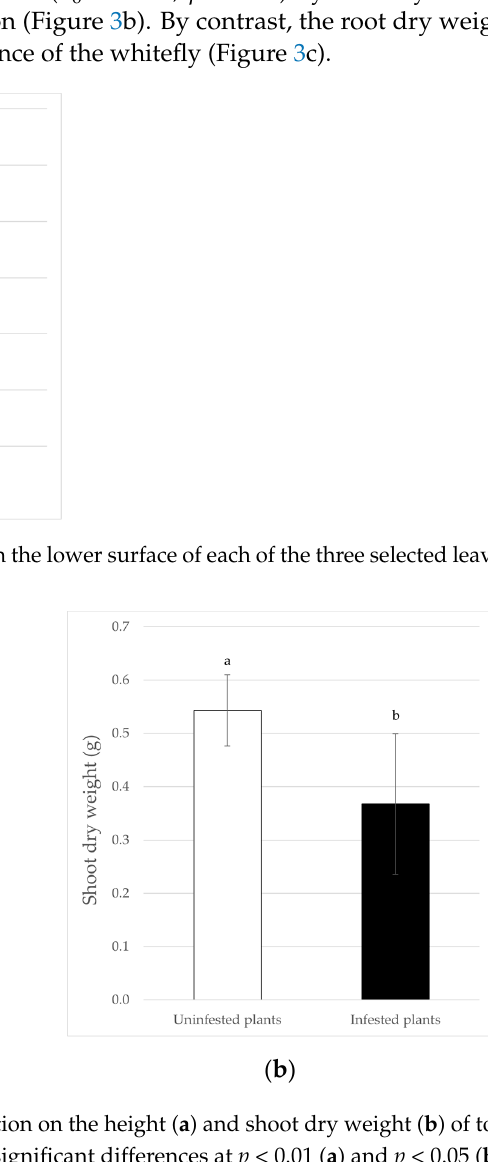
( c ) Figure 3. Effects of B. tabaci infestation on the leaf area ( a ), indirect chlorophyll content ( b ), and root dry weight ( c ) of tomato plants. Different letters indicate statistically significant differences at p < 0.05 ( a ) and p < 0.01 ( b ).